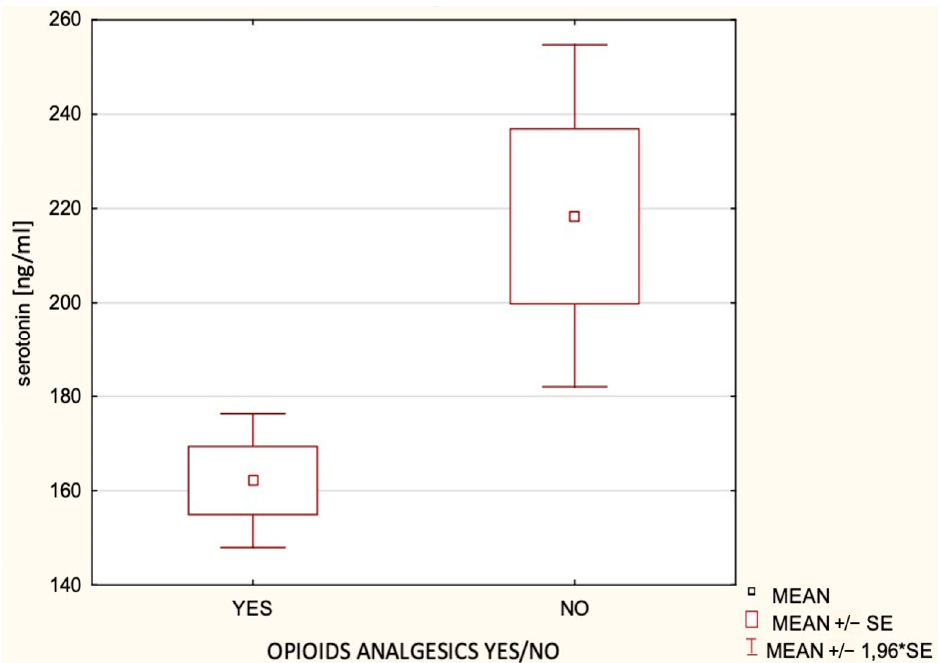
Figure 1. The relationship between serotonin concentrations and opioid requirement.